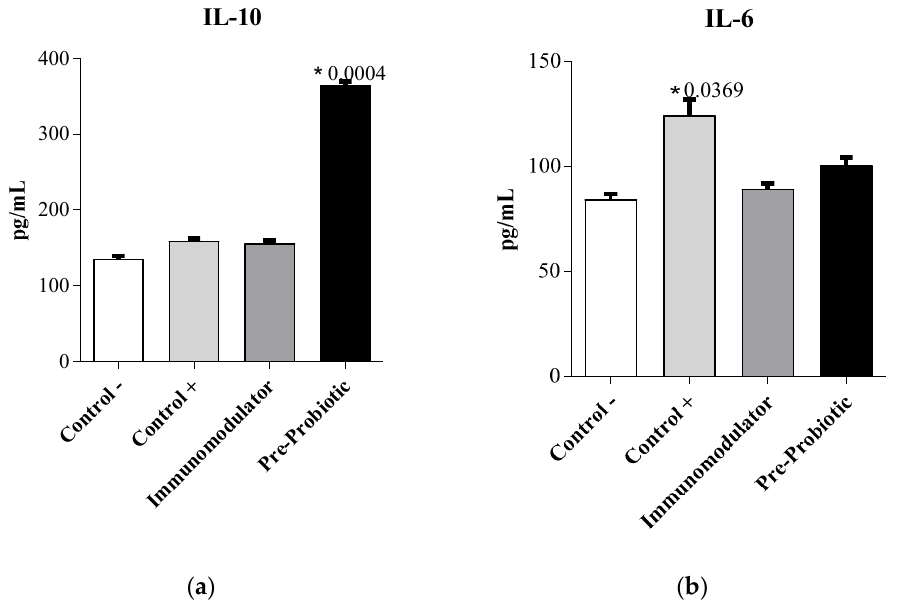
Figure 3. Levels of anti-inflammatory ( a ) IL-10 cytokine and pro-inflammatory ( b ) IL-6 cytokine of RAW murine macrophages treated with novel formulated products. Control − are untreated cells and Control + is positive control of cells treated with a suspension of E. coli 10 6 . * p < 0.05 .